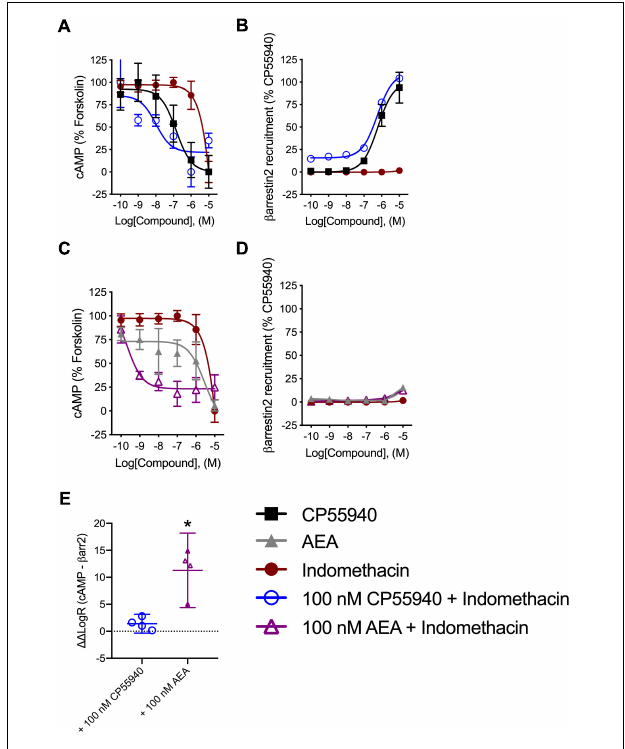
FIGURE 4 | Analysis of indomethacin bias at hCB1R in CHO cells. CHO HitHunter cAMP cells (A,C) or PathHunter β arrestin2 cells (B,D) stably expressing hCB1R were treated with 0.1 nM–10 µ M CP55940, AEA, indomethacin, 100 nM CP55940 + 0.1 nM–10 µ M indomethacin, or 100 nM AEA + 0.1 nM = 10 µ M indomethacin for 90 min. CHO HitHunter cAMP cells were also treated with 10 µ M forskolin. hCB1R-depednent inhibition of forskolin-induced cAMP accumulation (A,C) or β arrestin2 recruitment (B,D) was measured. Data are mean ± SEM. N = 5 in panels (A,C) , N = 6 in panels (B,D) . (E) Data were fit to the operational model to calculate (cid:49)(cid:49) LogR (cAMP– β arrestin2) such that values > 0 represent bias for inhibition of cAMP and values < 0 represent bias for recruitment of β arrestin2. Data are individually plotted with mean and 95% confidence interval. ∗ P < 0.05 compared to 0 as determined by 95% confidence interval. N =